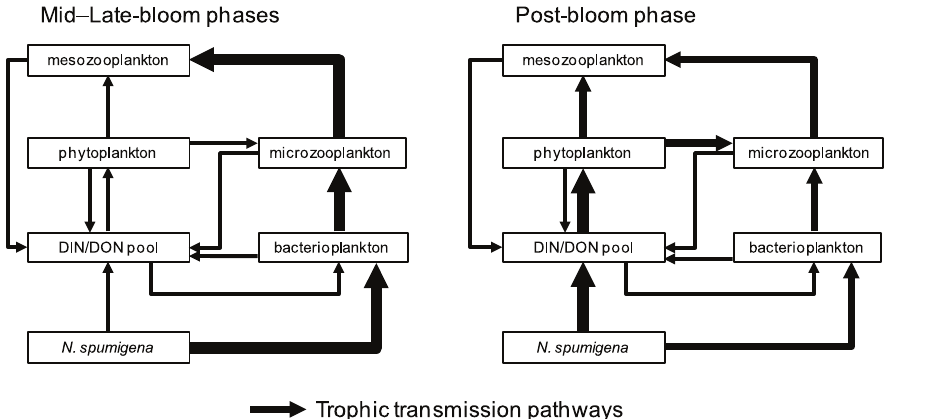
Figure 6. Simplified propagation pathways for diazotrophic nitrogen in a planktonic food web during different bloom phases. Simplified flow diagrams depicting differences in the primary pathways by which diazotrophic nitrogen (N D ) was transferred from Nodularia spumigena to different plankton groups during (left panel) and after (right panel) a N. spumigena bloom in Lake King, Australia. Vectors connecting boxes indicate direction and relative magnitude of N D flux through the food web. Contributions to the dissolved organic and inorganic nitrogen (DIN/DON) pool are included but have only been scaled for the relative contribution of N. spumigena . Plankton groups correspond with the following size-fractions: phytoplankton=0.7–63 m m, microzooplankton=80–149 m m, mesozooplankton $ 150 m